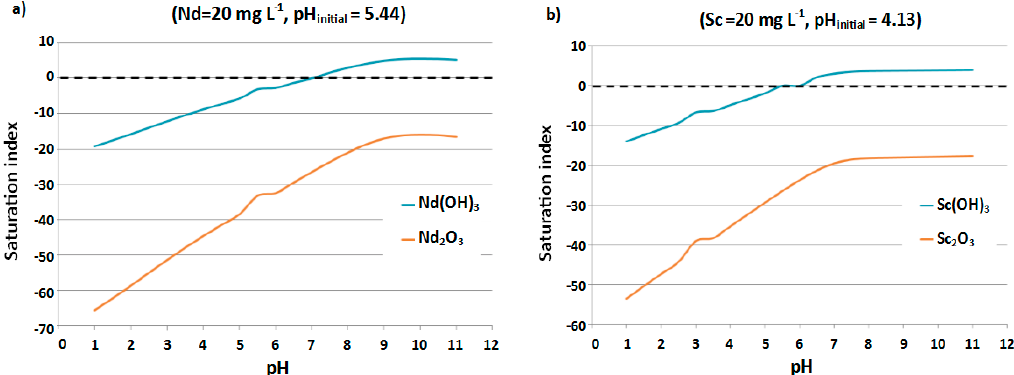
Figure 6. PHREEC-3 calculated saturation index (SI) values of potential solubility-controlling phases as a function of pH for (a) Nd and (b) Sc.